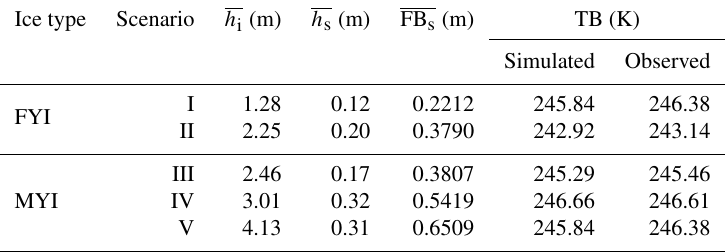
Figure 5. Typical distributions of FB s and the range of mean h s for 0 < α < 1. Panel (a) shows the four distributions (two for FYI and two for MYI) and the corresponding mean value of FB s . Global values of s for FYI and MYI are adopted. For these four distributions, panel (b) shows the mean h s for the range of α between 0 and 1. Mean h s increases monotonically with α and saturates when α is large. Table 1. Typical scenarios for retrievability studies. The mean sea ice thickness ( h i ), mean snow depth ( h s ), mean snow freeboard (FB s ), observed TB from SMOS and the simulated TB from forward radiation model are shown. Scenarios I and II are FYI, and scenarios III, IV and V are